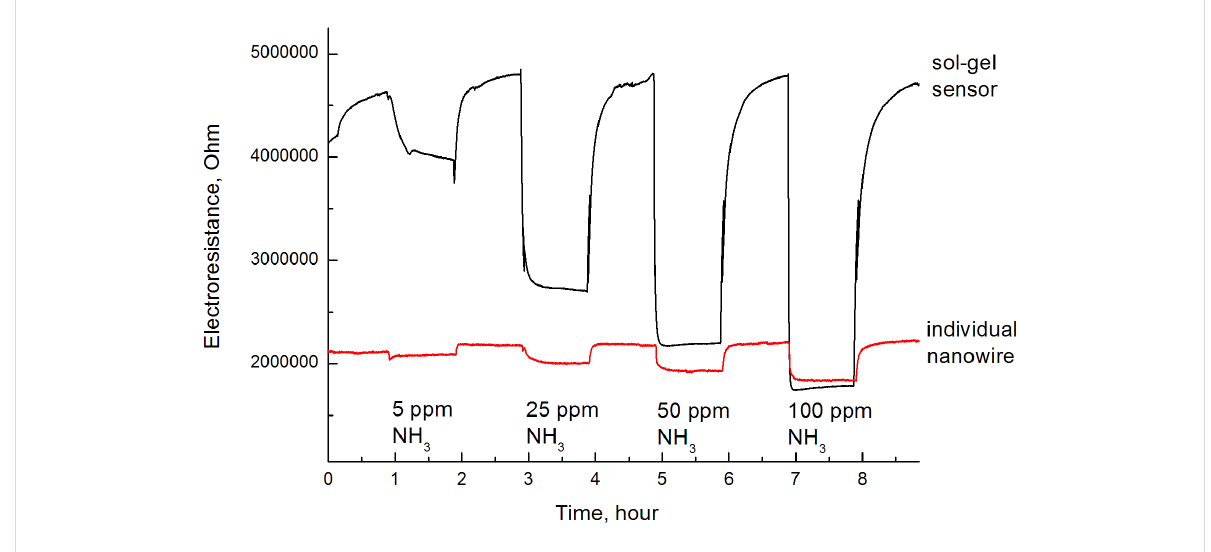
Figure 9: Response of nanowire and nanopowder sensors towards different concentrations of ammonia.